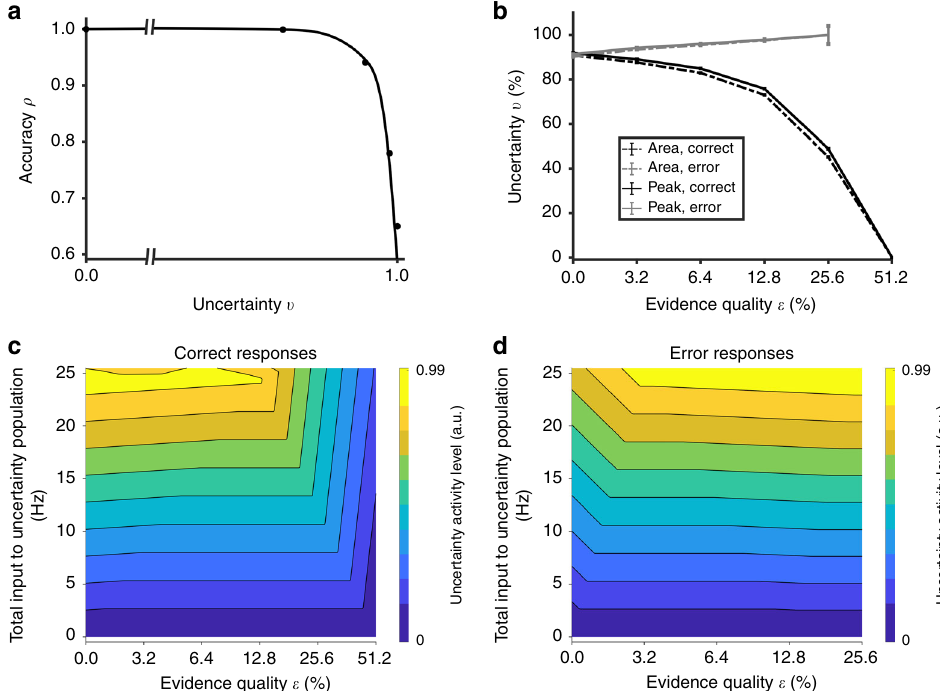
Fig. 2 Model accounts for behavioural patterns of decision uncertainty. a Choice accuracy as a function of decision uncertainty (based on peak value of uncertainty-encoding neuronal population activity). The break in the horizontal axis is at 0.6. b Decision uncertainty as a function of evidence quality ε . Grey (black): error (correct) choices. Bold (dashed): Uncertainty measure based on averaged peak (peak) or temporal integral (area) of the uncertainty- encoding neuronal population activity ( “ Methods ” ). Error bars are s.e.m. c , d Activity level of uncertainty-encoding population depends on the total input to the uncertainty-encoding population and evidence quality. Uncertainty activity level is normalized (see “ Methods ” ). c Correct responses. Activity of uncertainty-encoding population is higher for correct responses in dif fi cult tasks (lower ε ) due to prolonged response times (RTs) (Fig. 1d), allowing the uncertainty-encoding population longer time to integrate. See text for more detailed description. d Error responses. Activity of uncertainty-encoding population is higher during errors in easier tasks (higher ε ) due to prolonged RTs (Fig. 1d), allowing the uncertainty-encoding population longer time to